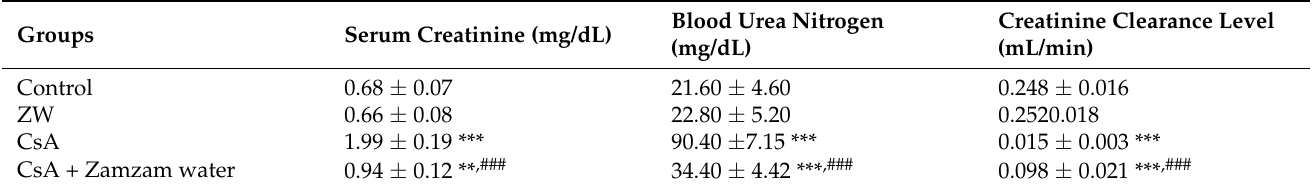
Table 2. The levels of serum creatinine, blood urea nitrogen, and creatinine clearance in the experi- mental groups.